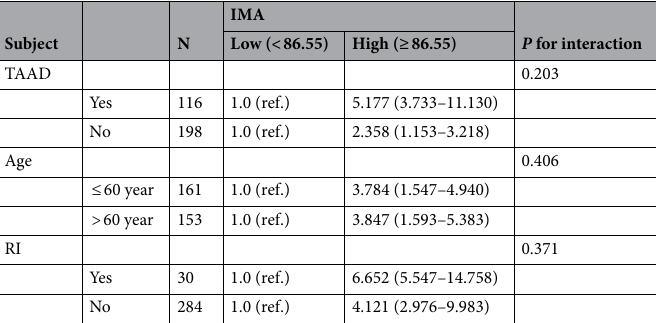
Table 7. Subgroup analysis of the correlation between IMA and in-hospital mortality of patients with AAD. AAD, acute aortic dissection; TAAD, Stanford type A aortic dissection; IMA, ischemic modified albumin; RI, renal